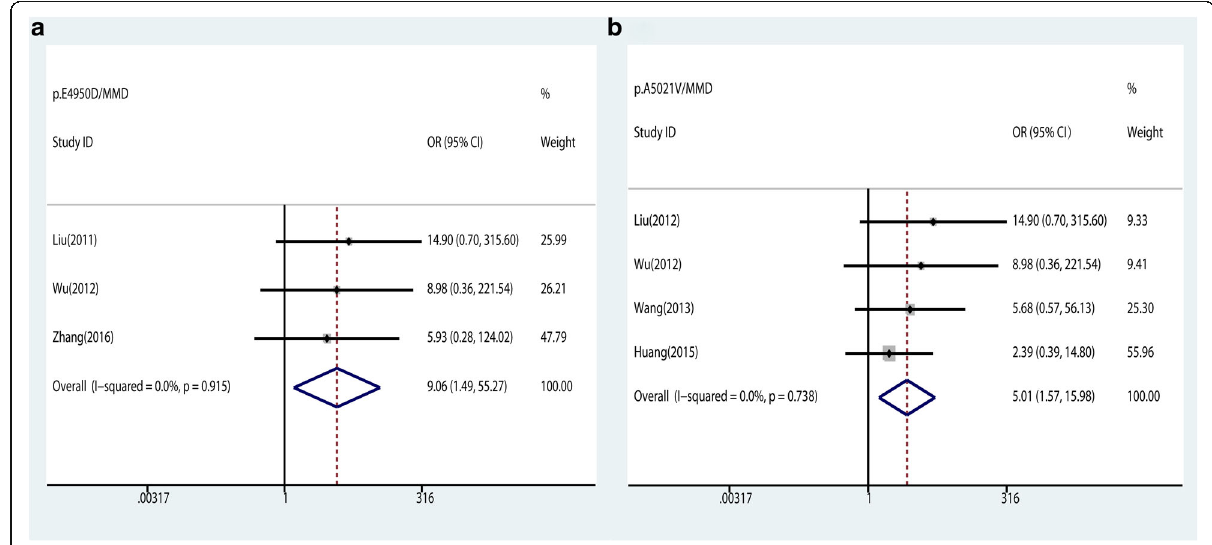
Fig. 3 Forest plots for the association of RNF213 p.E4950D and p.A5021V with MMD under the dominant model. a Forest plots of RNF213 p.E4950D and MMD in Chinese population under the dominant model. b Forest plots of RNF213 p.A5021V and MMD in Chinese population under the dominant model